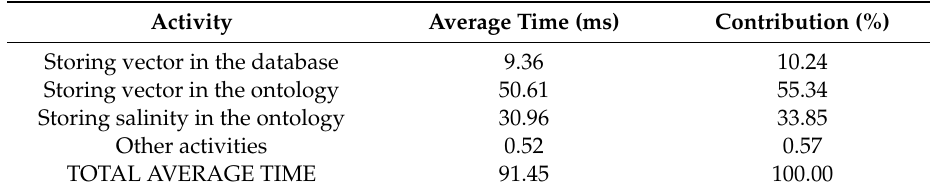
Table 8. Average time per activity for processing the state vector reports.